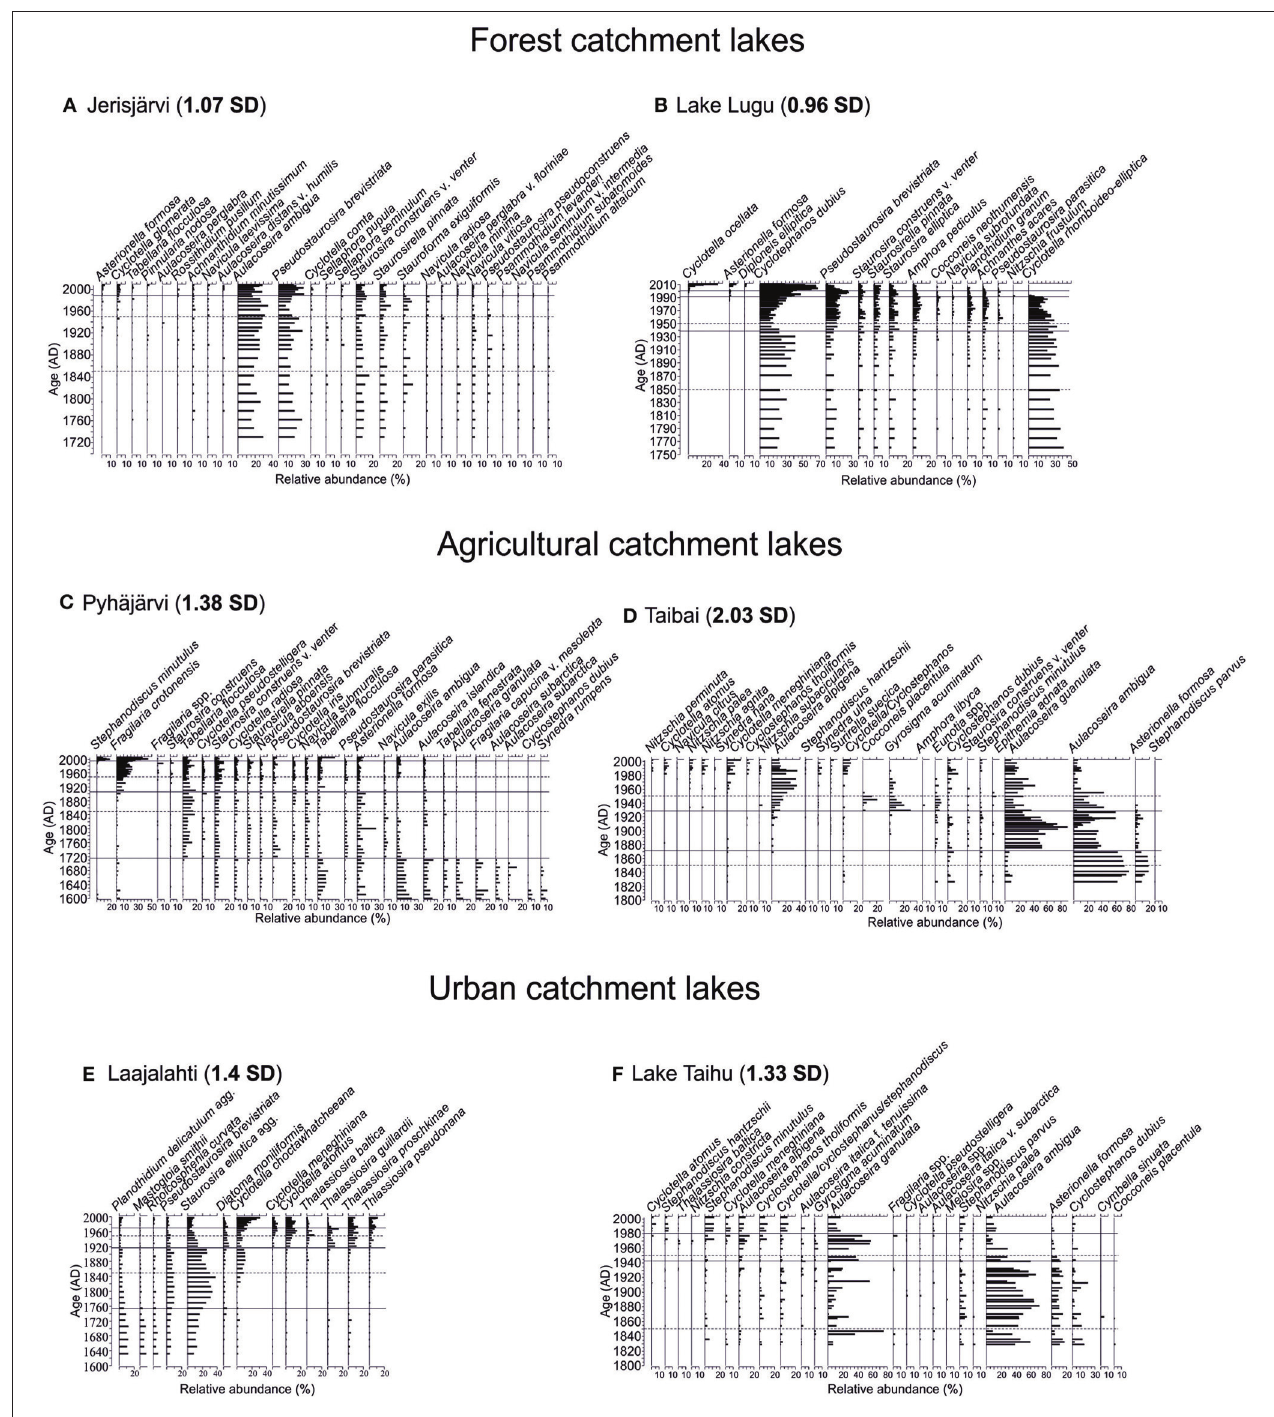
FIGURE 2 | Stratigraphic diagrams of the most common diatom taxa. The years 1850 and 1950, usually referred to as the timing of most intensive change of aquatic ecosystems (e.g., Bennion et al., 2004; Räsänen et al., 2006) are marked with a dashed line. The statistically significant diatom zones are marked with a solid line. Beta-diversity values (in SD units) are shown in bold next to each site’s name. The sites are arranged according to their catchment type: Forested catchments (A) Jerisjärvi, (B) Lake Lugu; Agricultural catchments, (C) Pyhäjärvi, (D) Lake Taibai; and Urban catchments, (E) Laajalahti, (F) Lake Taihu.